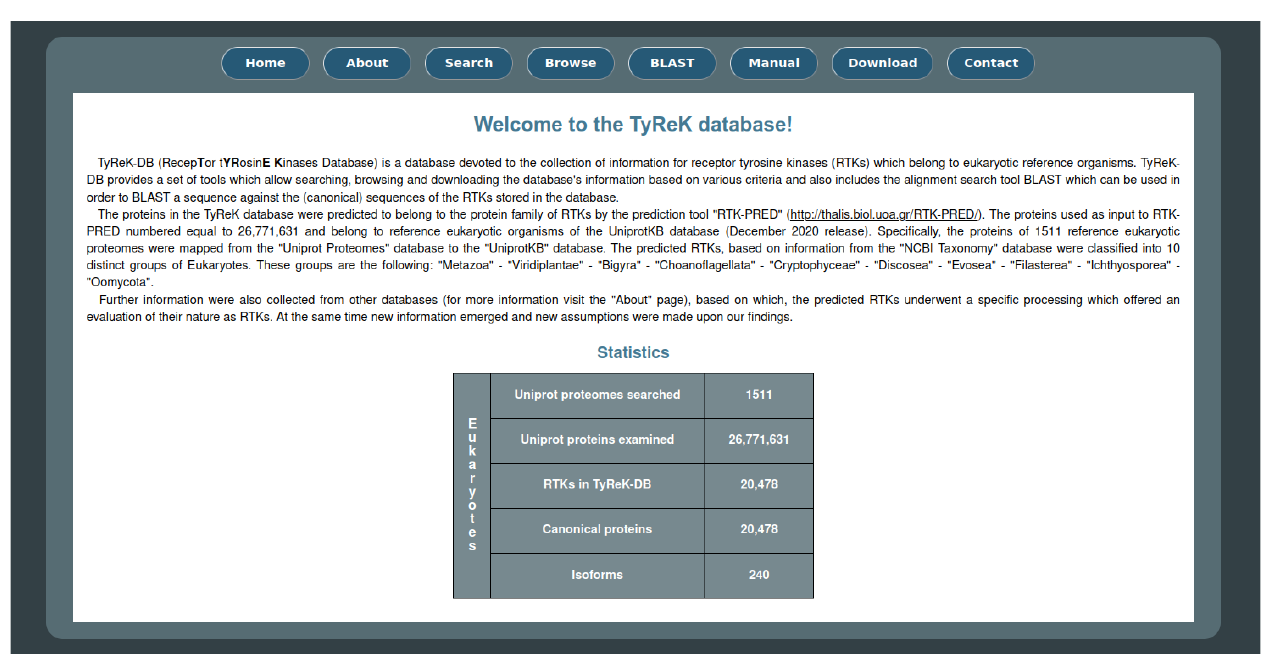
Figure 4. The main interface of the homepage of the TyReK-DB website.